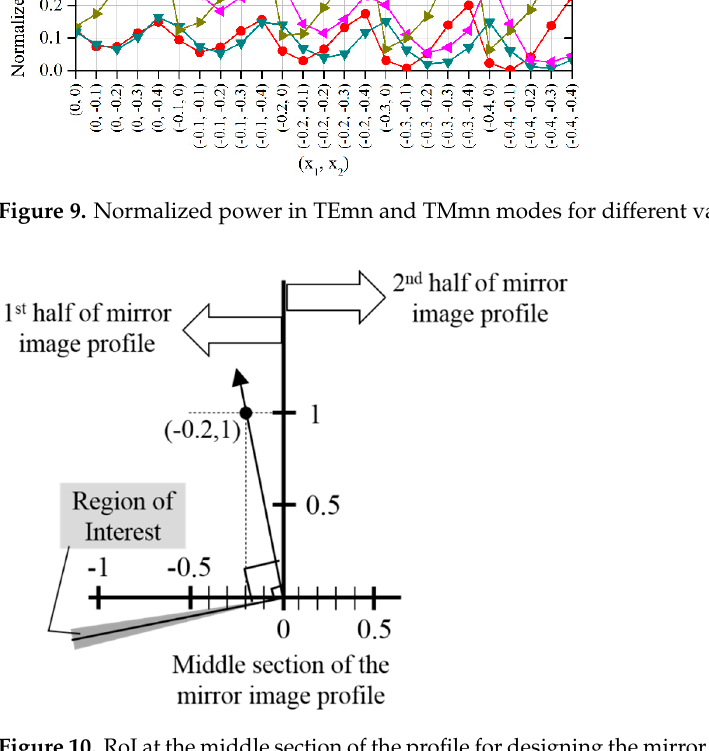
Figure 10. RoI at the middle section of the profile for designing the mirror image profile horn an- tenna.